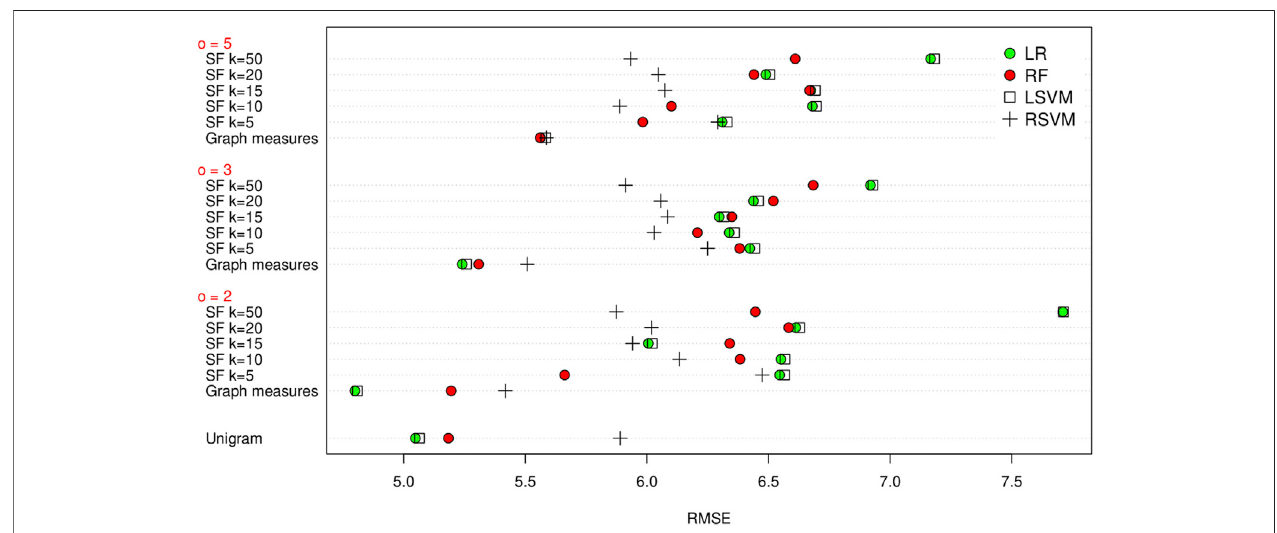
FIGURE 4 | RMSE of the unigram, graph measures and SF methods for leave one out cross validation on the training set, grouped by co-occurrence window size ( o ∈ { 2 , 3 , 5 } ).